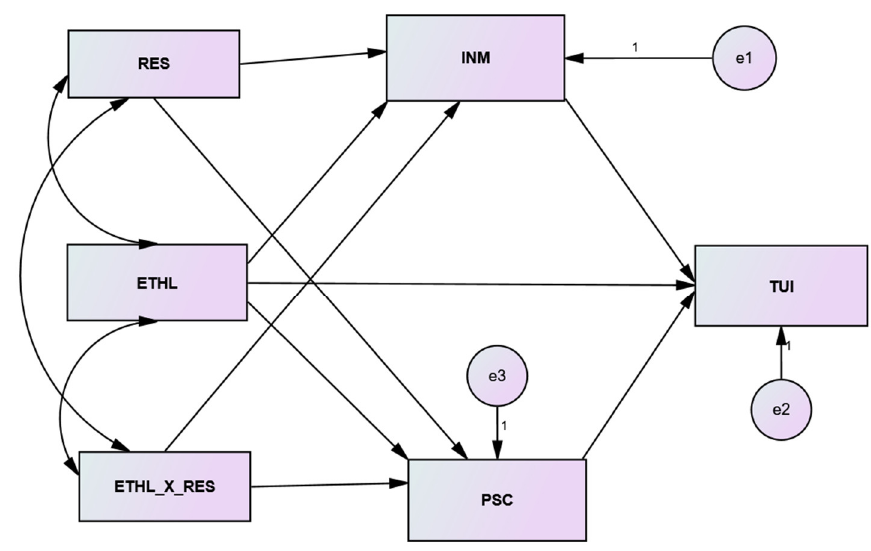
Figure 1. The hypothesized structural model: ETHL = ethical leadership (X); INM = intrinsic motivation (M1); PSC = psychological contract (M2); TUI = turnover intentions (Y); RES = resilience (W); ETHL_ × _RES = interaction term.